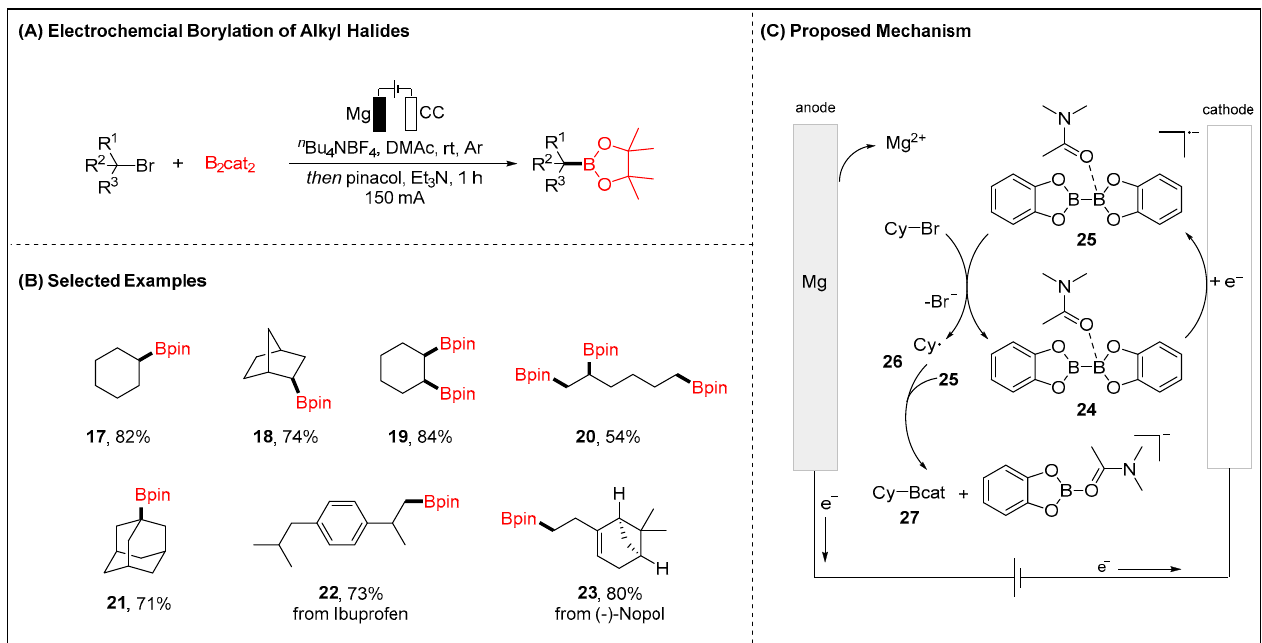
Figure 5. Electrochemical borylation of alkyl halides for alkyl boronic